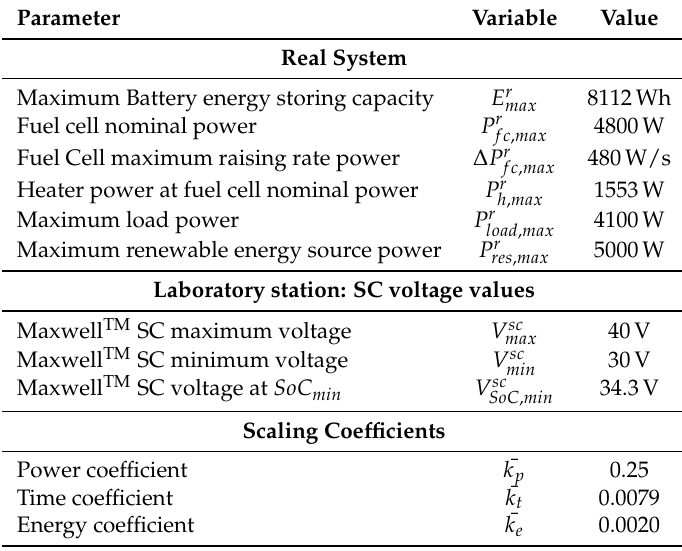
Table 8. Experimental validation data and parameters of the scaling methodology.